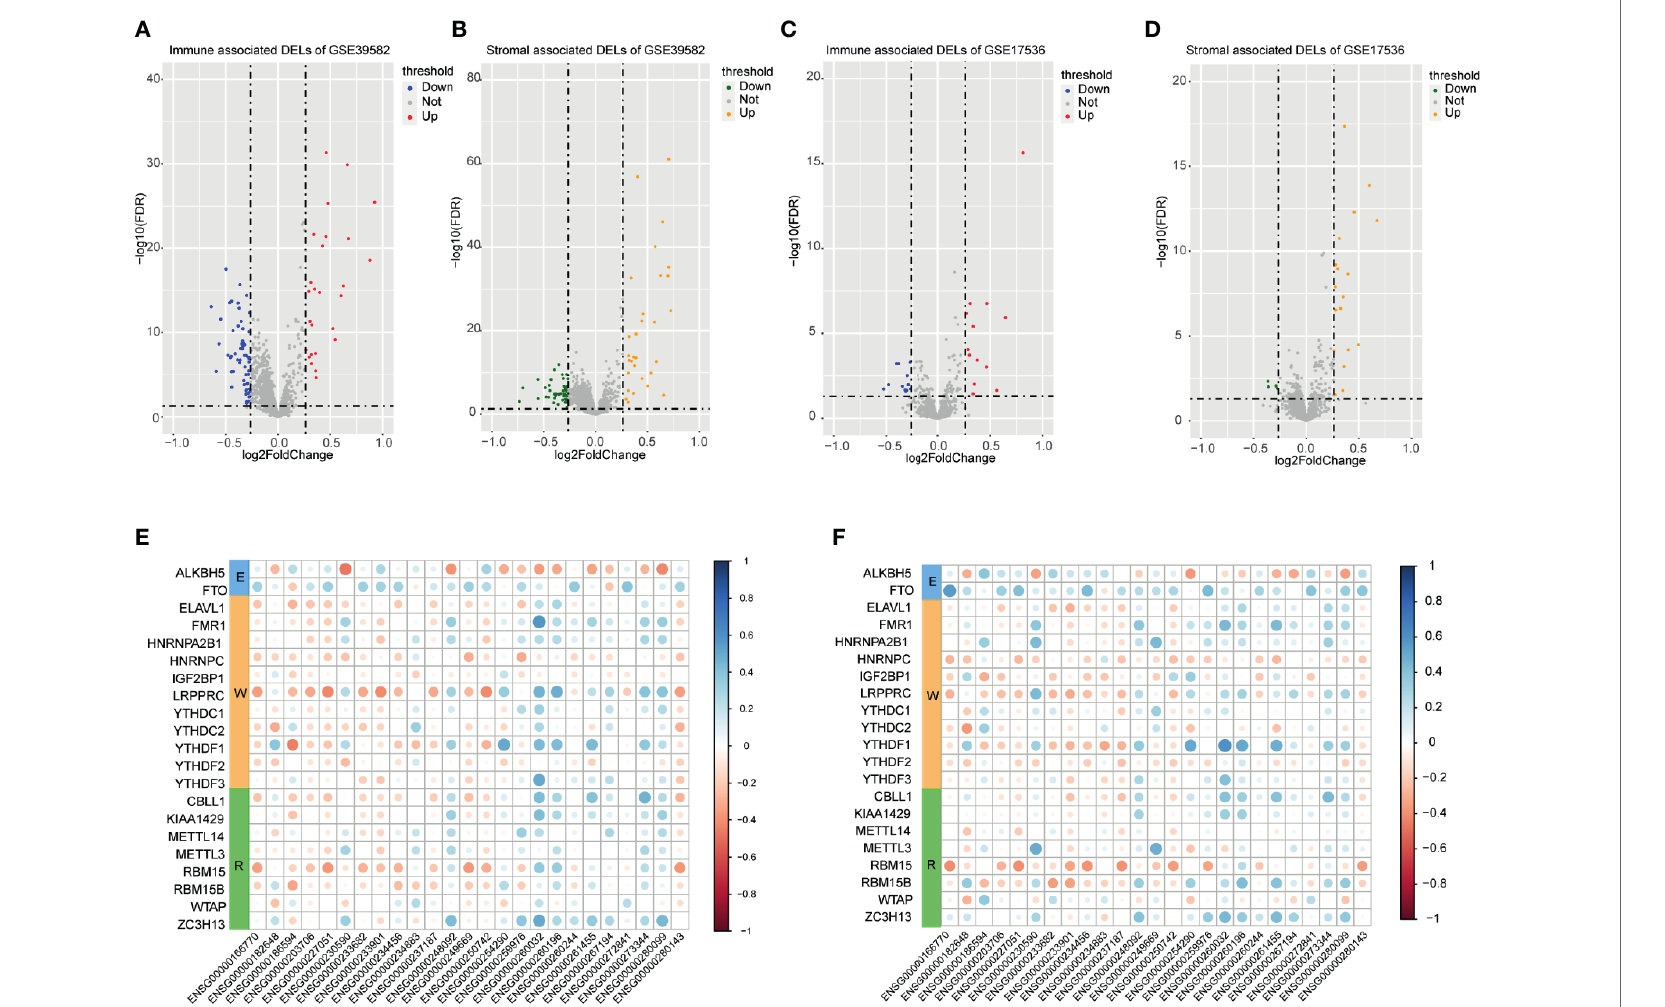
FIGURE 2 | Analysis of microenvironment associated DEGs and Pearson analysis. (A) Differential expressed immune associated lncRNAs in GSE39582 data set. (B) Differential expressed stromal associated lncRNAs in GSE39582 data set. (C, D) Differential expressed immune and stromal associated lncRNAs in GSE17536 data set, respectively. (E, F) The correlational heatmap showed coef fi cient between the common 25 crucial lncRNAs and m6A